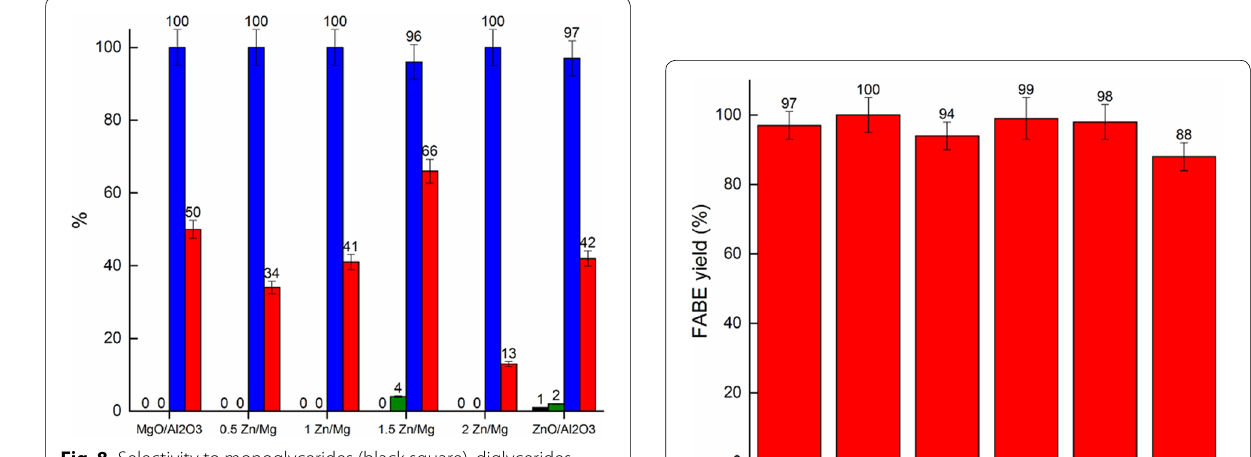
Fig. 8 Selectivity to monoglycerides (black square), diglycerides (green square) and FAME (blue square), and FAME yield (red square) obtained for each catalyst, in the transesterification of soybean oil with butanol